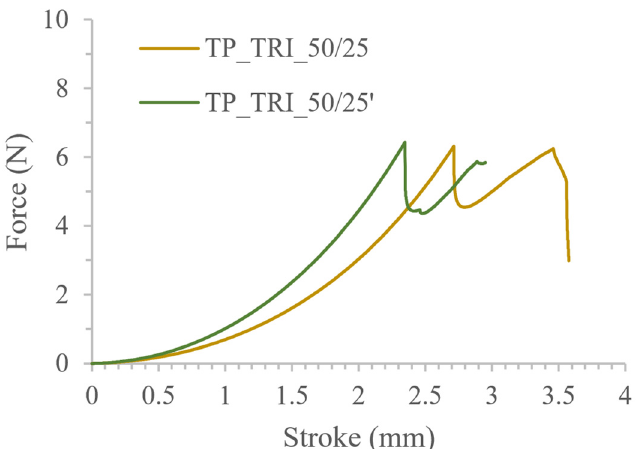
Figure 8. Comparison of the mechanical properties of tablets made of fresh and reused resin containing triethanolamine.